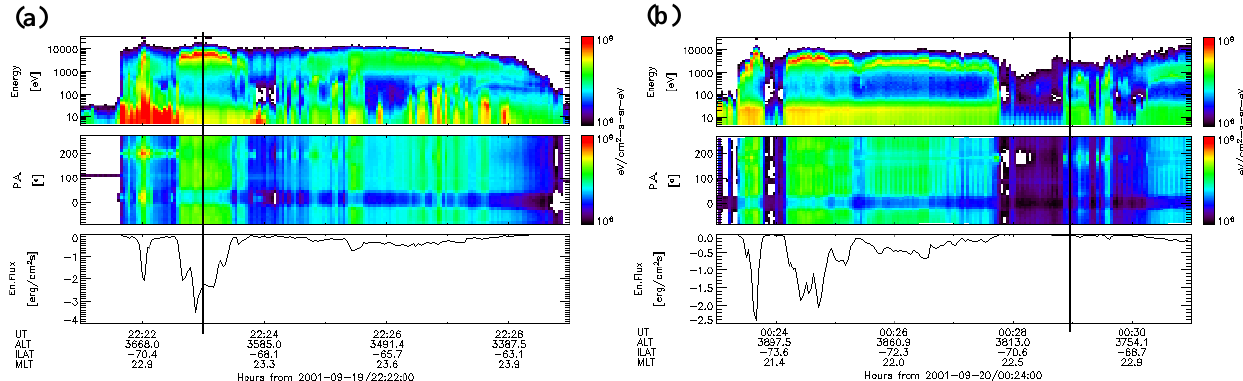
Fig. 5. FAST data for (a) the conjunction at 22:23 UT, on 19 September 2001, and (b) the conjunction at 00:29 UT, on 20 September 2001. The actual conjunctions are indicated by the vertical black lines. The top and middle panels show the electron energy and pitch angle spectrograms. The bottom panels show the electron energy flux at the satellite level.